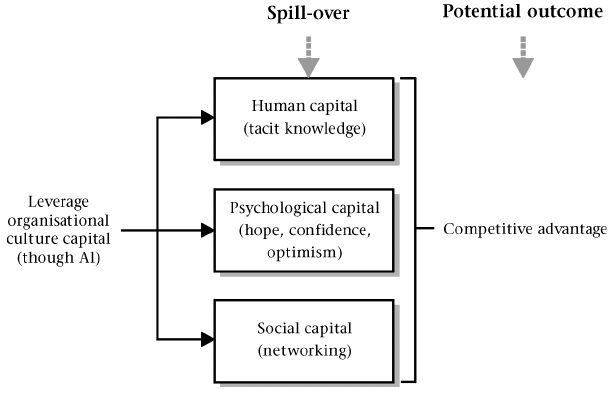
Figure 4: The spill-over effect and the potential impact of leveraging organisational cultural capital through